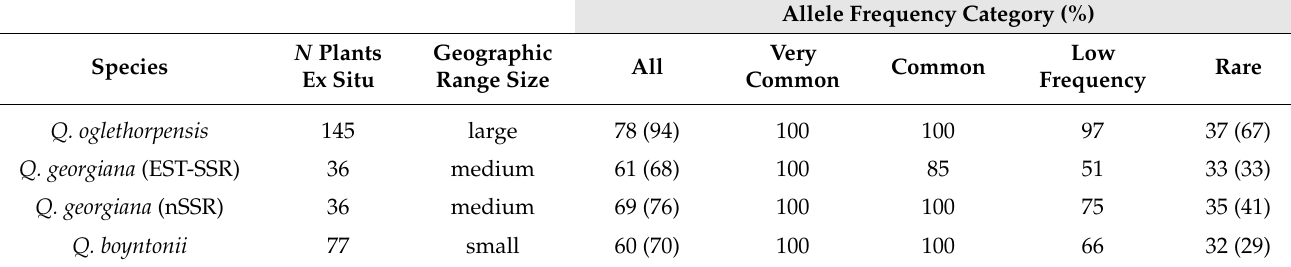
Table 3. Percent allele capture in ex situ collections. The percent of alleles conserved in ex situ collections, for different allele frequency categories, for each species. Allele frequency categories are: all (all alleles); very common alleles (>10%); common alleles (>5%); low (<10% and >1%); and rare (<1%). For rare alleles and all alleles, two results are presented, percentage captured when all alleles including those with fewer than two occurrences are included (complete data), and when alleles with one or two occurrences are excluded (reduced data, shown in